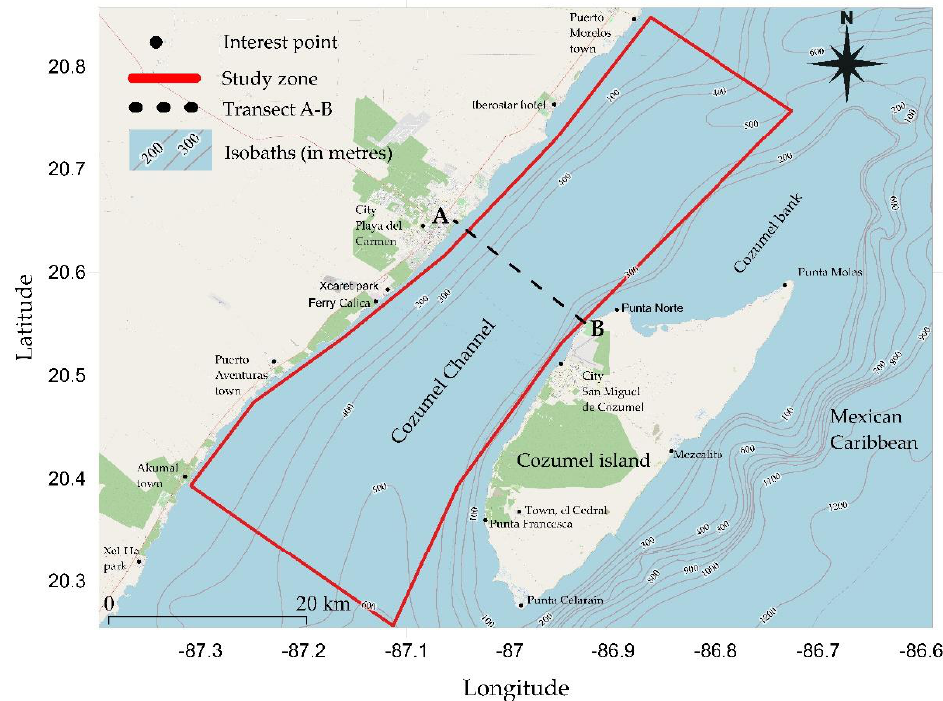
Figure 2. Bathymetry of the Cozumel channel. Isobaths show meters. The transect A – B shows the line of the bathymetric profile seen in Figure 3.